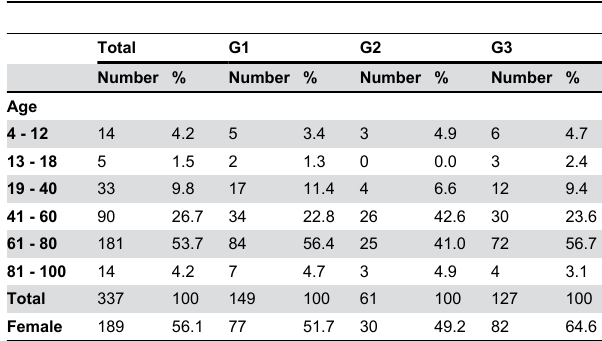
Table 1. Number of examinees in the internal radiation exposure screening